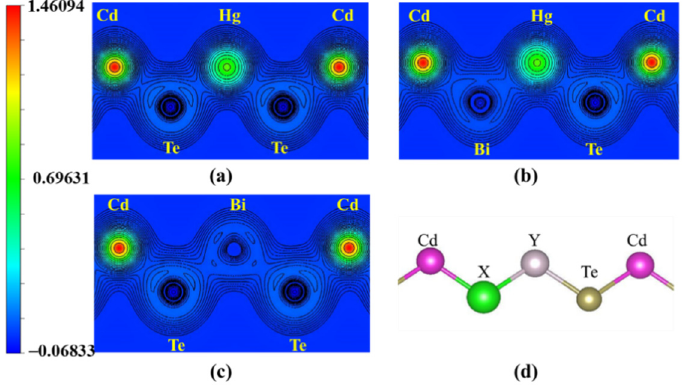
Figure 2. The valence charge density (2D) in the (1, 0, − 1) plane for ( a ) undoped Hg 0.75 Cd 0.25 Te, ( b ) the in situ impurity Bi Te in Hg 0.75 Cd 0.25 Te, and ( c ) the in situ impurity Bi Hg in Hg 0.75 Cd 0.25 Te. ( d ) Local structure around Bi impurity.